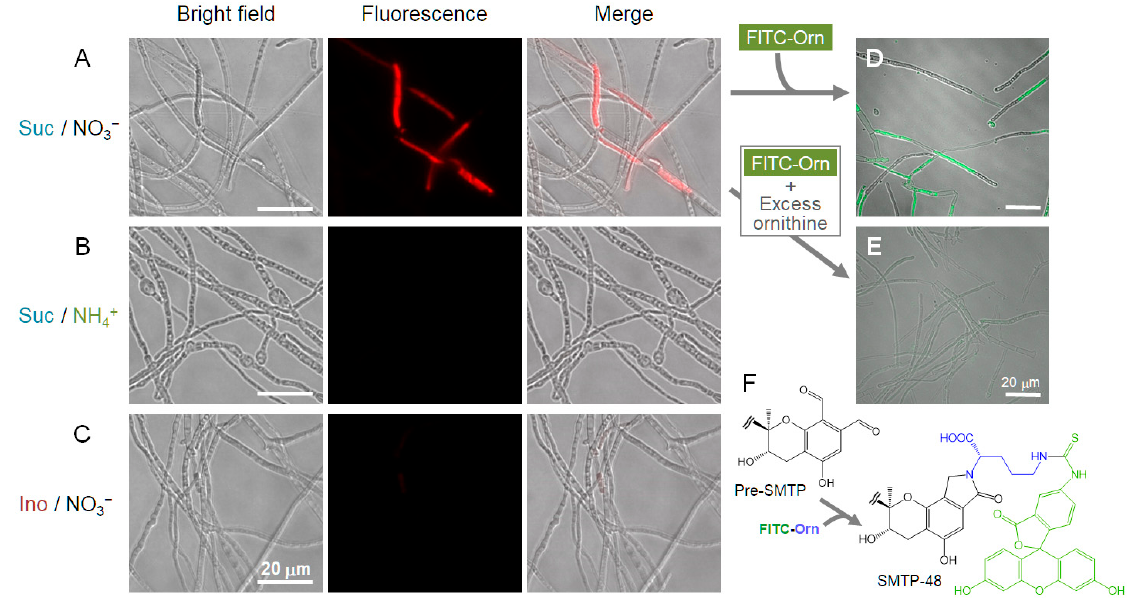
Figure 7. Localization of pri-SMTP biosynthesis. Fluorescence microscopic localization of pri-SMTP accumulation in S. microspora grown on different nutrients: Suc/KNO 3 ( A ), Suc/NH 4+ ( B ), and Ino/KNO 3 ( C ) (excitation at 560 nm and emission at 630 nm). Medium abbreviations are the same as